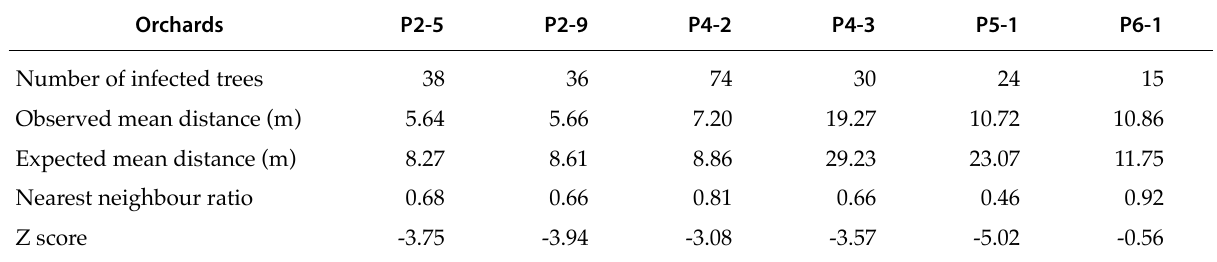
Table 4. Nearest neighbour distances between infected trees in six orchards with fire blight affected trees in Zaragoza